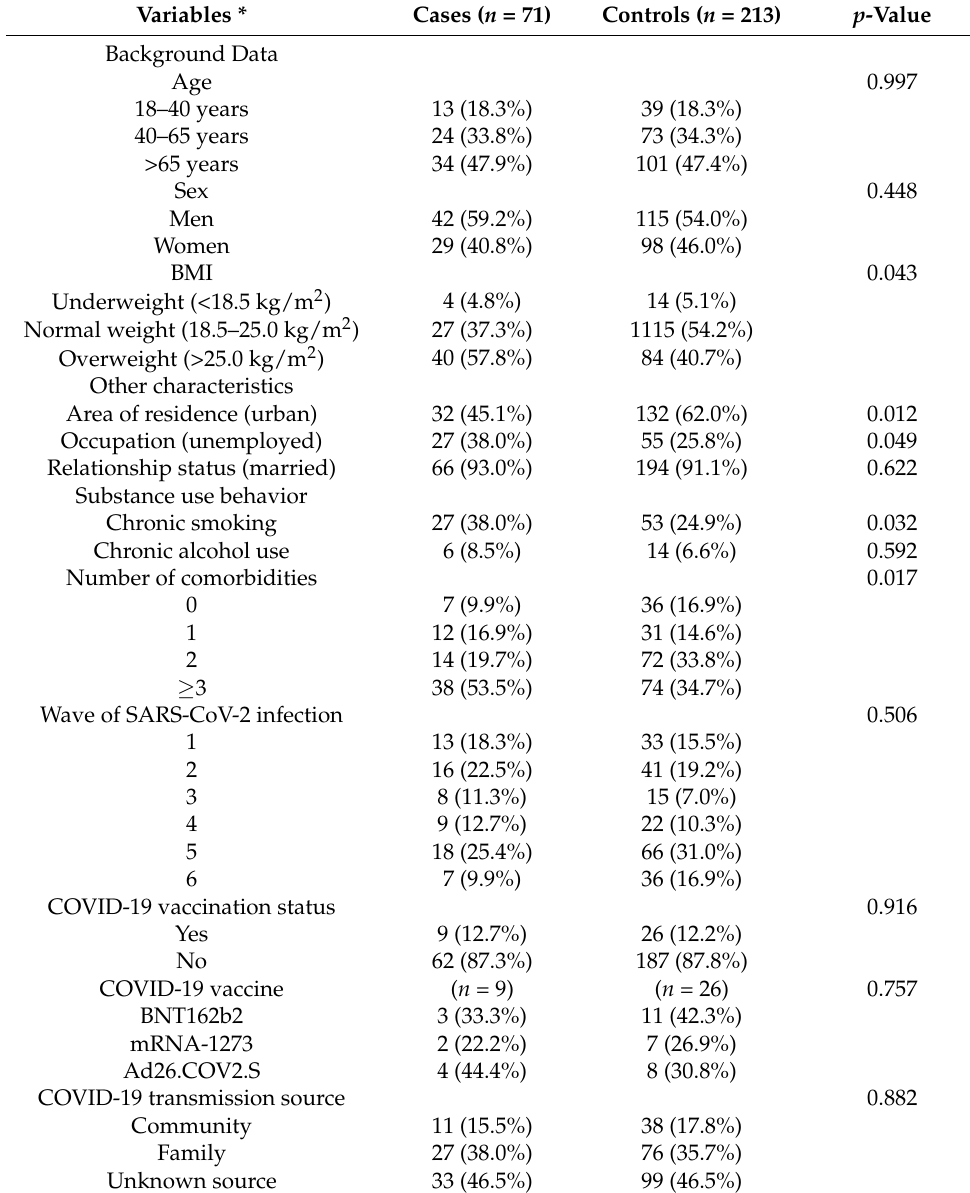
Table 1. Comparison of baseline characteristics between cases and controls with COVID-19 admitted to the ICU.